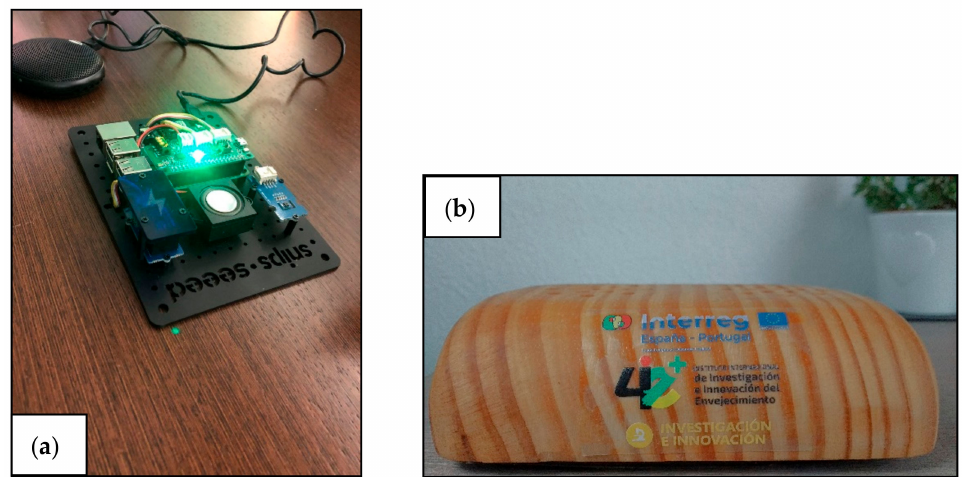
Figure 2. Current appearance of Assistant on Health and Care Offline (ACHO): ( a ) internal and ( b )